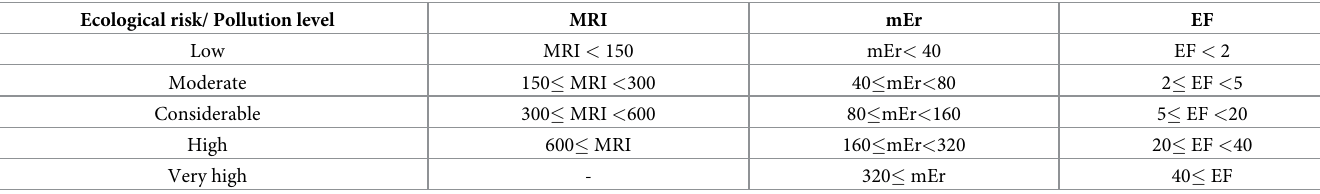
Table 1. Potential ecological risk based on mEr and MRI and Enrichment Factor (EF) levels. Ecological risk/ Pollution level MRI mEr EF Low MRI <